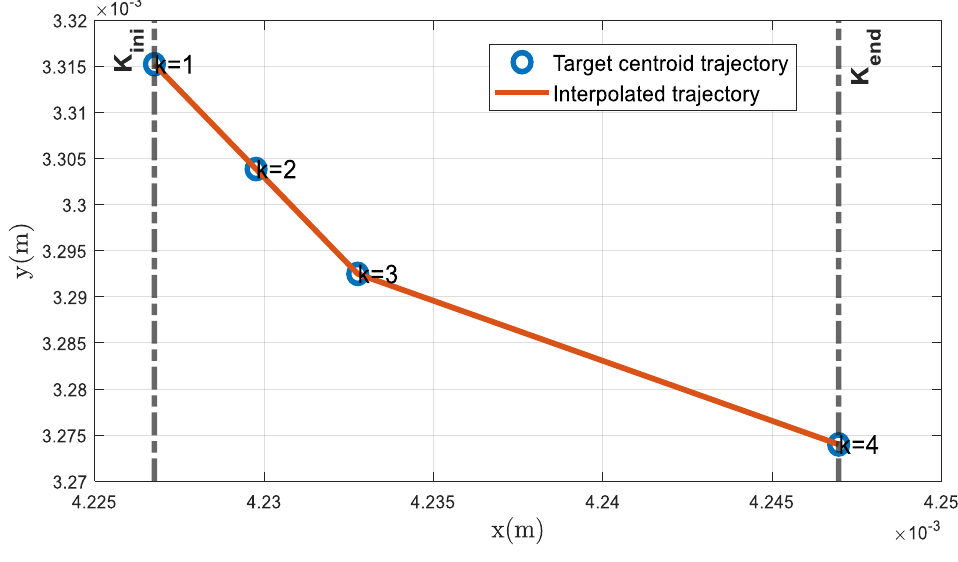
Figure 7. LoS vectors from Camera 1 to Target 1 𝑳𝒐𝑺(cid:4652)(cid:4652)(cid:4652)(cid:4652)(cid:4652)(cid:4652)(cid:4652)⃗ (cid:2869),(cid:3038),(cid:2869)(cid:3050) ,𝑘 = 1,...,4 in the image plane in {W} coordinates during the time window 𝑲 (cid:3038)(cid:2869) and the interpolated trajectory. The data will be stored in the information vectors 𝒊 (cid:2869),(cid:3038),(cid:2869)(cid:3050) = {𝑘;𝑶 (cid:3030),(cid:2869)(cid:3050) ;𝑳𝒐𝑺(cid:4652)(cid:4652)(cid:4652)(cid:4652)(cid:4652)(cid:4652)(cid:4652)⃗ (cid:2869),(cid:3038),(cid:2869)(cid:3050) } for each k -th instant within the time window 𝑲 (cid:3038)(cid:2869) .